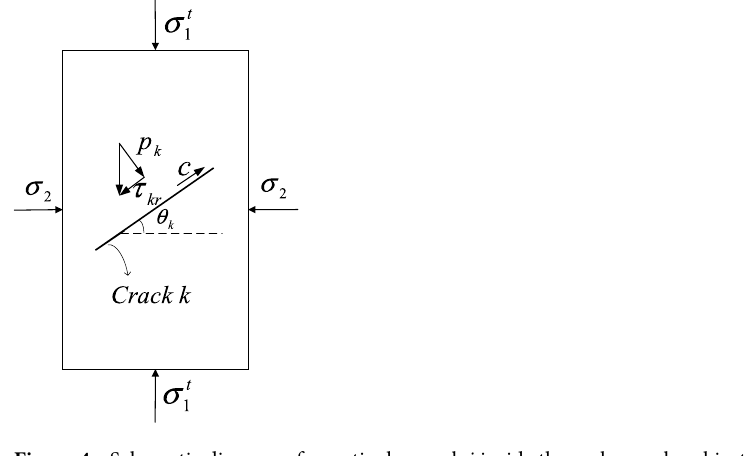
Figure 4. Schematic diagram of a particular crack i inside the rock sample subjected to